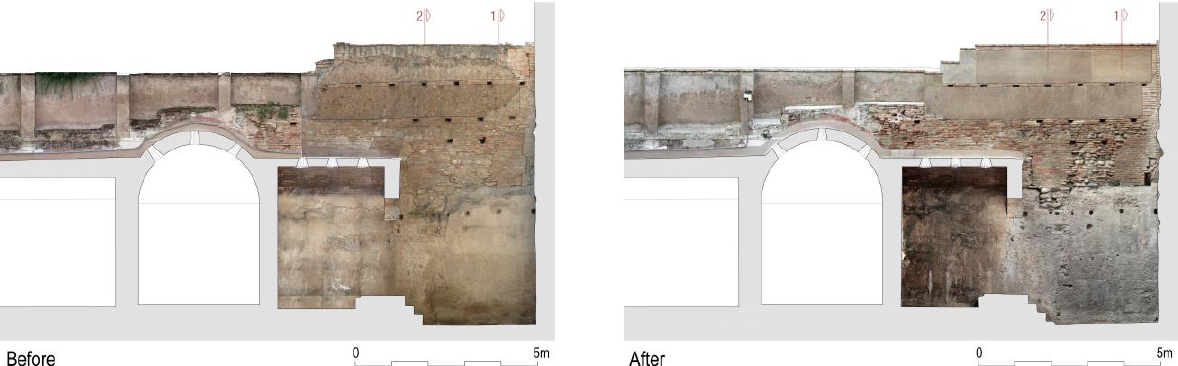
Figure 2. Elevation of the west dividing wall of the Bañuelo. State before and after the consolidation works (section pl. 1-2